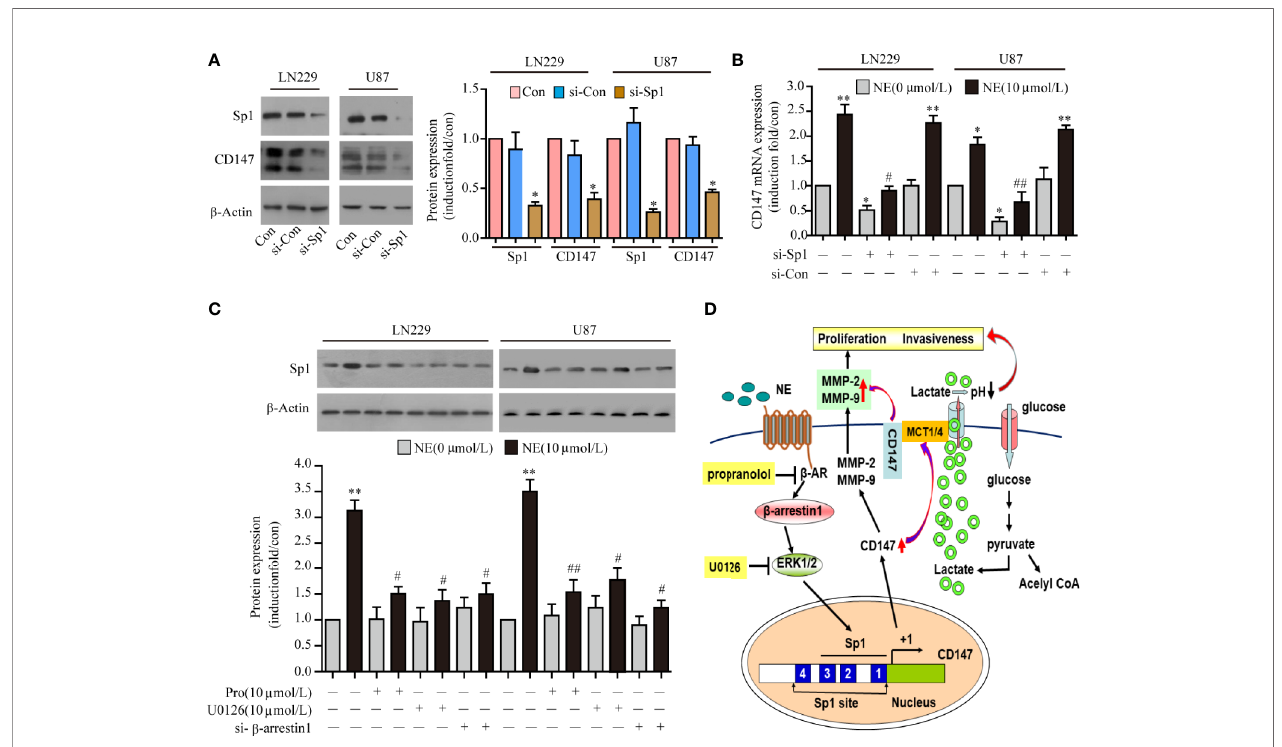
FIGURE 6 | Norepinephrine (NE) Regulated CD147 Expression by Activating the b -AR/ b -Arrestin1/ERK/Sp1 Pathway. (A) Expression of CD147 and Sp1 protein and statistical analysis (B) and mRNA in LN229 and U87 cells after transfection with Sp1 siRNA. (C) Effects of U0126, si- b -arrestin1 or Propranolol on NE-induced Sp1 expression in LN229 and U87 cells. (D) Schematic diagram of how NE regulates the expression of CD147 through the b - adrenergic receptor- b -arrestin1-ERK- Sp1 pathway. *P < 0.05, **P < 0.01, compared with 0 m mol/L NE; # P < 0.05, ## P < 0.01 compared with 10 m mol/L